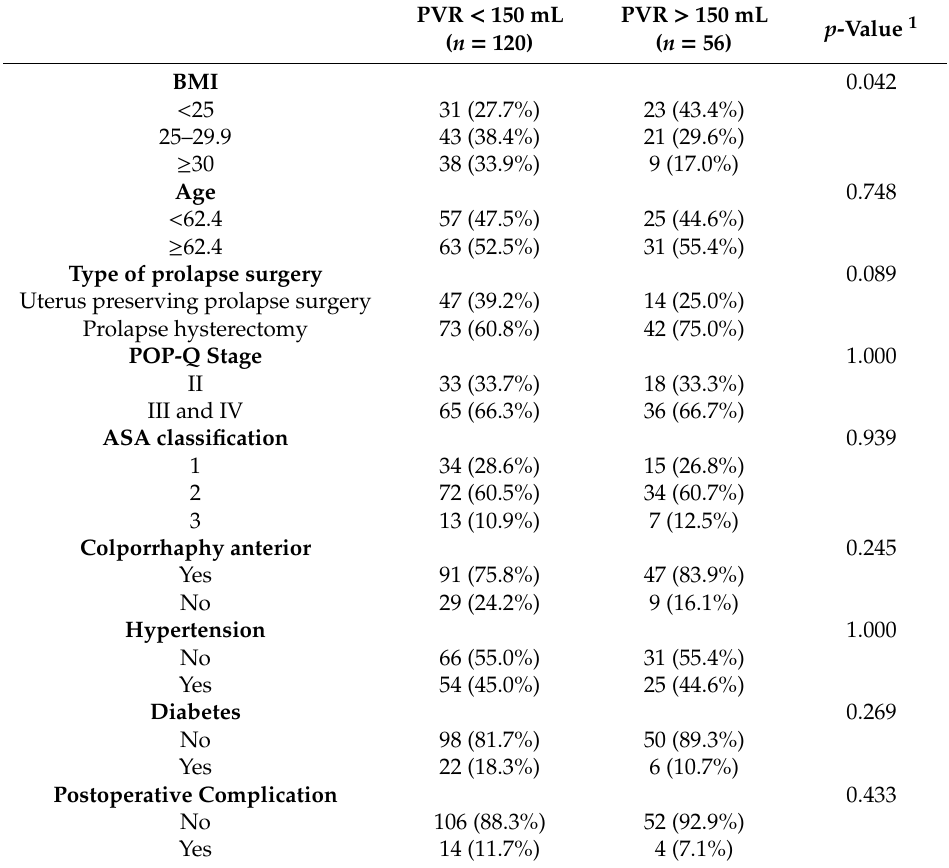
Table 2. Relationship between urogynecologic as well as clinical parameters and post-void residual (PVR) in 176 patients. Cut-o ff for significant PVR was defined as amounts > 150 mL.